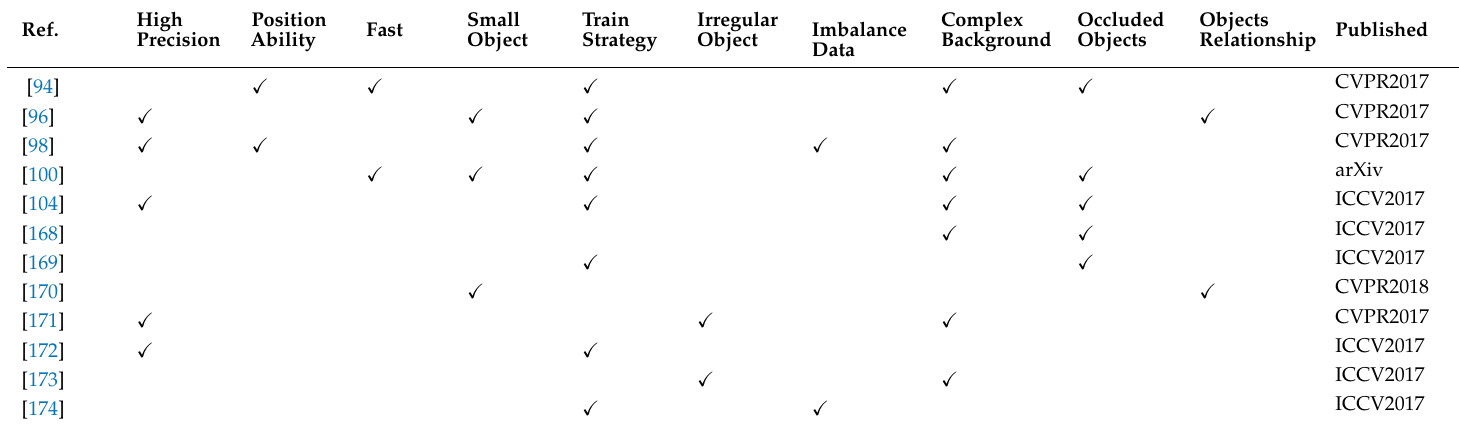
Table 6. Summary of object detection methods with high precision, high positioning, fast detection, small object, complex background, occluded object detection.